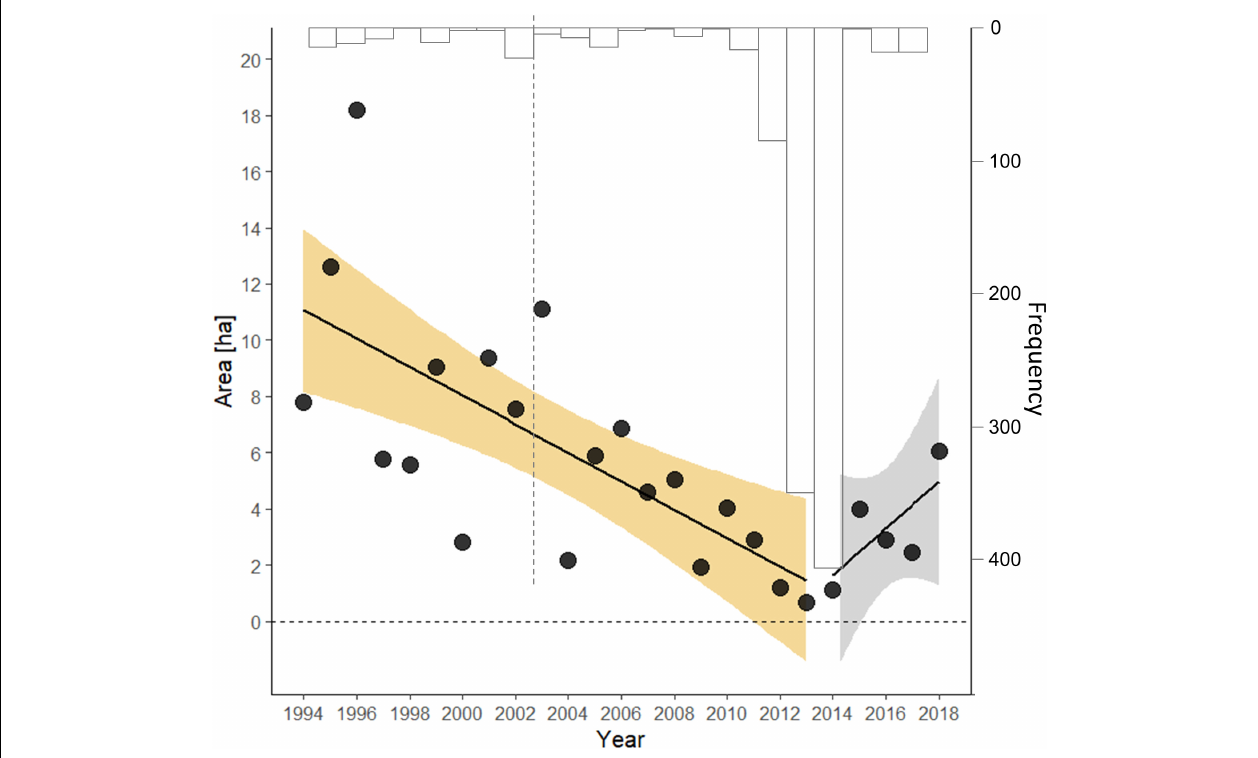
FIGURE 1 | Segmented time series of the index of overwinter abundance [in area occupied (ha)] of eastern migratory monarch butterflies. The bootstrapped frequency of the changepoint estimate from 10 3 replicates is provided (inverted, in gray); the gray line represents the lower 2.5% symmetric bootstrap confidence